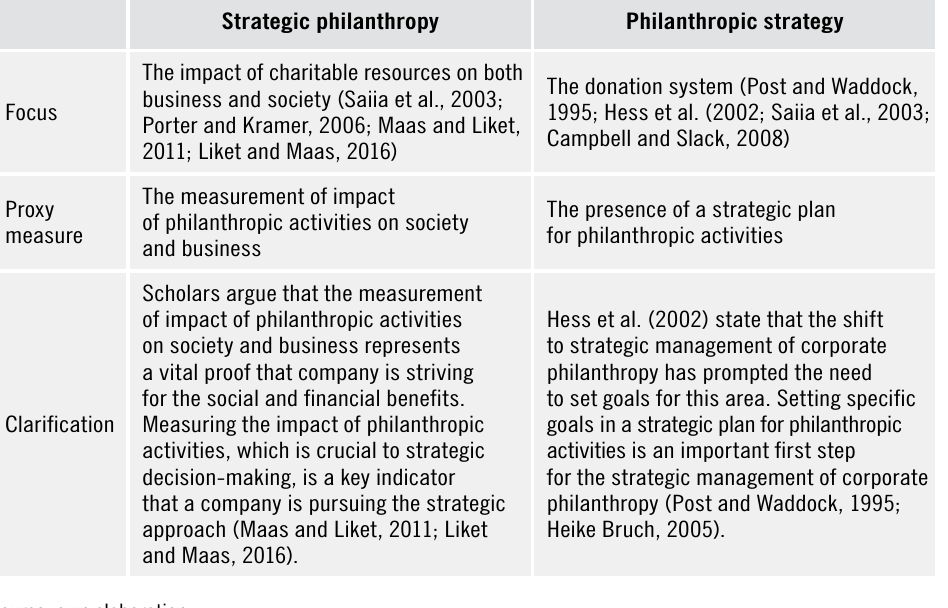
Table 1. Main features of strategic approaches to corporate